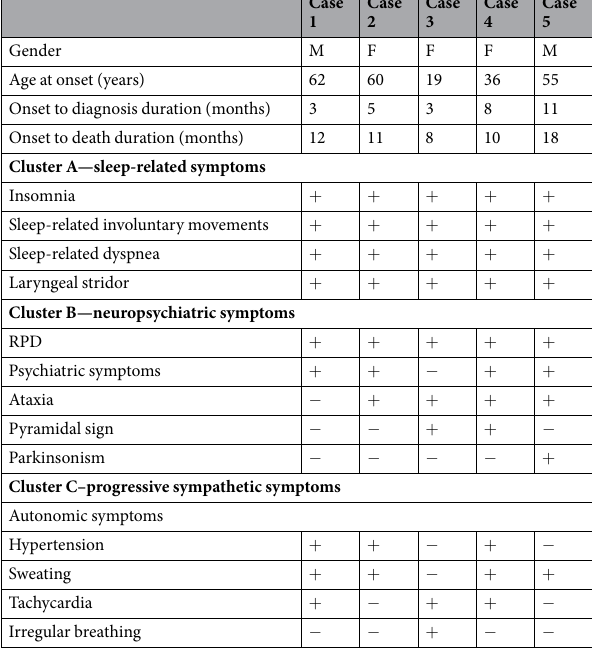
Table 1. Clinical characteristics of the five FFI patients. RPD: rapidly progressive dementia. + : symptom/sign observed, − : symptom/sign not observed. Psychiatric syndromes included hallucination, personality change, depression, anxiety, aggressiveness, disinhibition, listlessness etc. Autonomic signs include hypertension, sweating, tachycardia, irregular breathing etc. Sleep-related involuntary movements included frequent changes in the body position and twitchy non-purposeful movements of limbs during